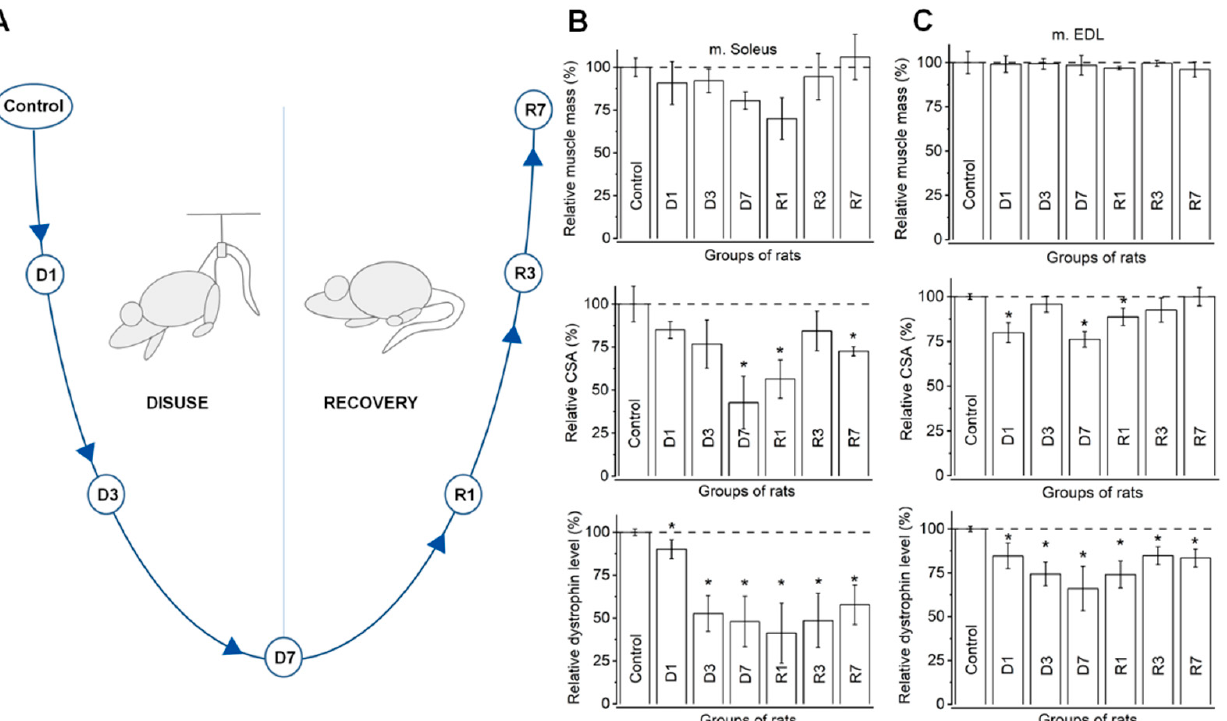
Figure 1. Design the U-experiment: morphometric and dystrophin fluorescence intensity analysis in muscle fibers during different time-points of disuse and recovery. ( A ) Time points of the muscle sampling during the disuse (Dx) and recovery (Rx) stage of the experiment. Estimation of relative muscle mass and relative cross-section area in m. Soleus ( B ) demonstrates significant decline after the seventh day of disuse to the first day of recovery, while in fast muscle, m. EDL ( C ) there are no significant changes. When assessing dystrophin fluorescence intensity in slow muscle m. Soleus ( B ), a significant decrease in dystrophin content during the third and seventh days of disuse, and the first day of the recovery period, is observed, followed by a slight increase until the seventh day of recovery. In m. EDL ( C ), a significant decline in dystrophin content after the third to the seventh day of disuse, and a rise on the first day of recovery, is also demonstrated. In total, 100% of the values for the control group were accepted. The significant differences are indicated by asterisks. See Supplementary Table ST1 for full data.